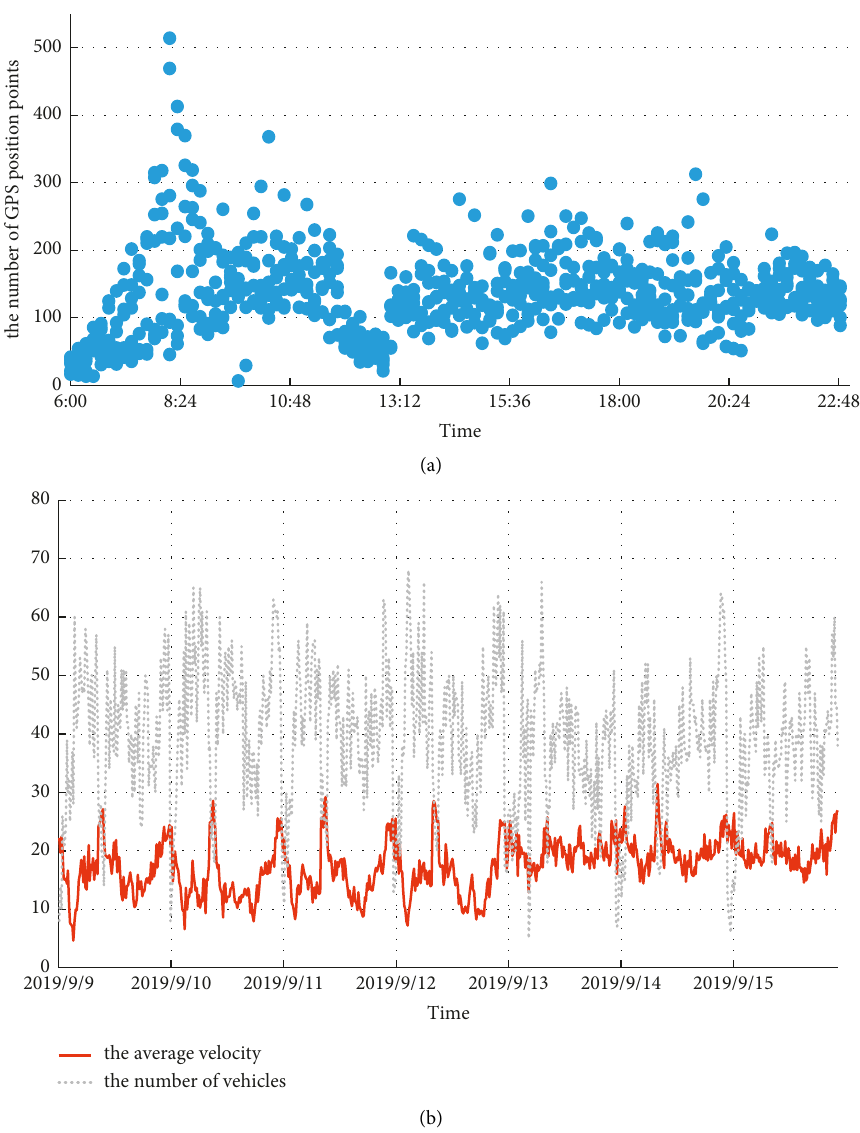
Figure 9: The variation trend of each attribute information in grid (3, 2). (a) The variation trend of the number of GPS position points. (b) The variation trend of the average speed and the number of